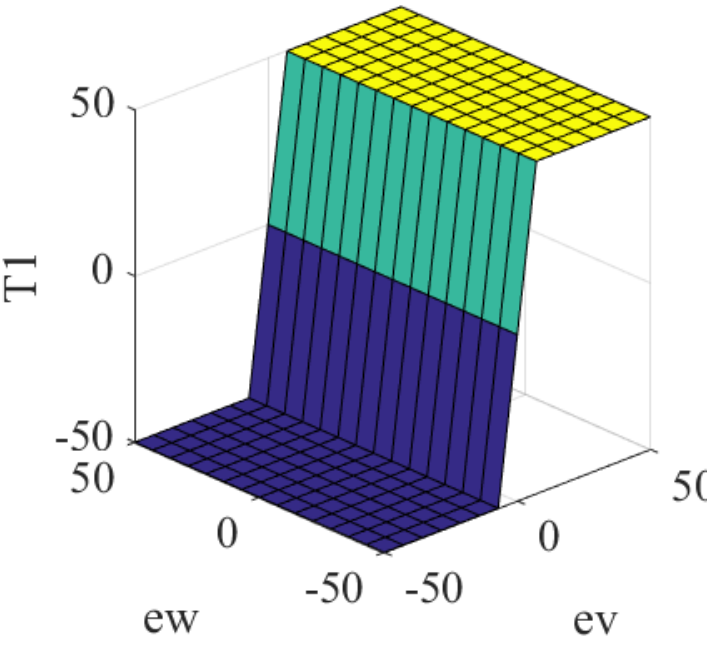
Figure 9. Surface of the mobile robot controller.